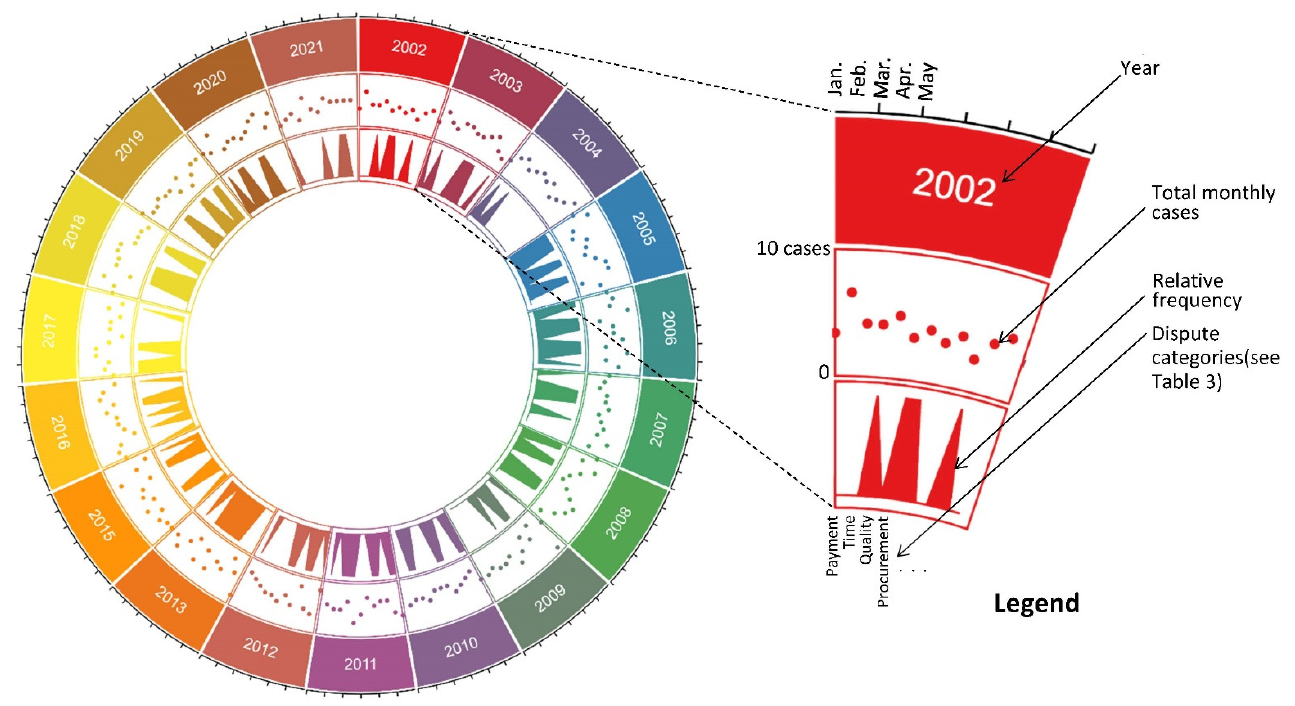
Figure 11. Visualization of dispute categories frequencies for all studied cases.